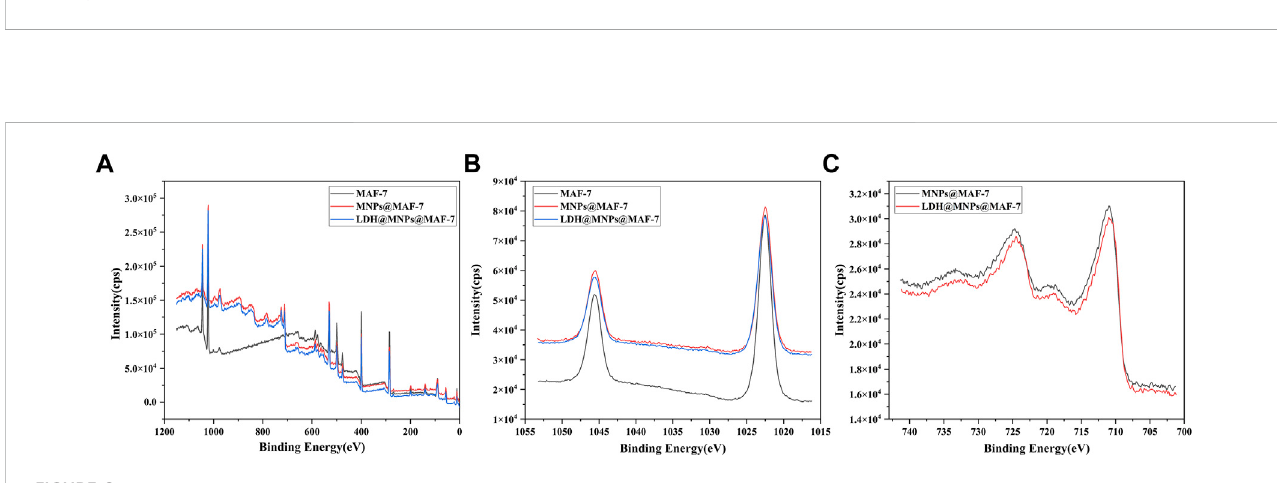
FIGURE 5 (A) Magnetic properties of Fe 3 O 4 , MNPs@MAF-7 and LDH/MNPs@MAF-7 at 300 K (Right inset: separation of the LDH/MNPs@MAF-7 particles from aqueous solution using an external magnetic fi eld) (B) The magni fi ed curves of MNPs@MAF-7 between -100 and 100 Oe (C) The magni fi ed curves of LDH/ MNPs@MAF-7 between -100 and 100 Oe.